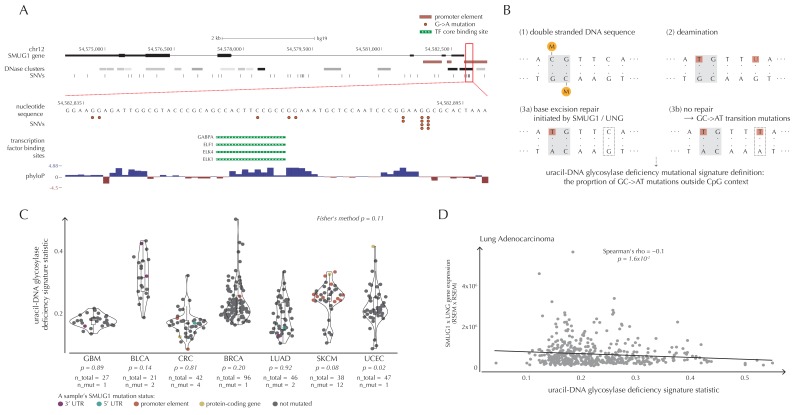
SMUG1 mutations and base excision repair.(A) Genomic overview of SMUG1 showing its promoter region (Kent et al., 2002). The DNase clusters track shows DNase hypersensitive regions where the darkness is proportional to the maximum signal strength observed in any cell line (ENCODE Project Consortium, 2012). The transcription-factor-binding sites (TFBSs) track shows core regions of transcription factor binding (Gerstein et al., 2012). The phyloP track shows evolutionary conservation of positions (Pollard et al., 2010). (B) Uracil-DNA glycosylase deficiency signature definition: (1) Cytosines may be methylated (orange circles) at CpG sites (gray box). (2) Spontaneous deamination (red boxes) of non-methylated cytosine results in uracil, causing U:G mismatches. Spontaneous deamination of methylated cytosine results in thymine, causing T:G mismatches. (3a) SMUG1 and UNG are uracil-DNA glycosylases, which, via base excision repair, will repair the U:G mismatches caused by deamination. (3b) If unrepaired, the U:G mismatches will result in G→A mutations. (C) A one-sided Wilcoxon rank sum test is performed per cancer type to investigate if samples with a SMUG1 mutation have a higher value of the uracil-DNA glycosylase deficiency signature statistic than samples without such a mutation. The analysis is based on the 505 whole genome TCGA samples. Each dot represents a sample, and the color represents the SMUG1-associated mutated element. (D) Correlation between the uracil-DNA glycosylase deficiency signature statistic and the product of SMUG1 and UNG gene expression using TCGA exome data for lung adenocarcinoma.DOI:
http://dx.doi.org/10.7554/eLife.21778.02910.7554/eLife.21778.030Figure 6—source data 1.The defined uracil-DNA glycosylase deficiency signature statistic for each sample of the cancer types GBM, BLCA, CRC, BRCA, LUAD, SKCM and UCEC.For each sample, the SMUG1 mutation status is indicated. This data set relates to Figure 6C.DOI:
http://dx.doi.org/10.7554/eLife.21778.03010.7554/eLife.21778.031Figure 6—source data 2.The defined uracil-DNA glycosylase deficiency signature statistic, as well as SMUG1 gene expression, UNG gene expression, and SMUG1xUNG gene expression for TCGA exome samples.Expression values are RSEM values. This data set relates to Figure 6D as well as Figure 6—figure supplement 1.